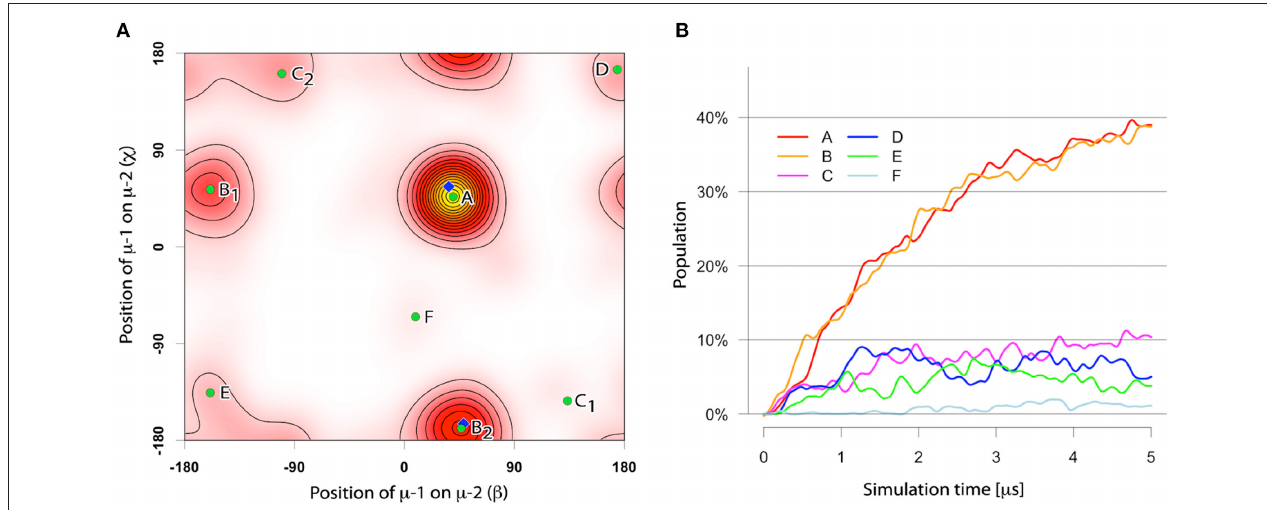
FIGURE 2 | (A) The distinct binding modes of the mIgM-TMD assembly described by ORIANA and defined by β and χ -angles. β describes the position of monomer µ -2 with respect to monomer µ -1. χ describes the binding site of monomer µ -1 on monomer µ -2. For details please see (30, 34). Green dots mark the peaks of the bound conformers. Blue diamonds mark the β - and χ -angles of the selected representative structures for BM-A and BM-B conformers. (B) Population of different TM dimer configurations as a function of simulation time.